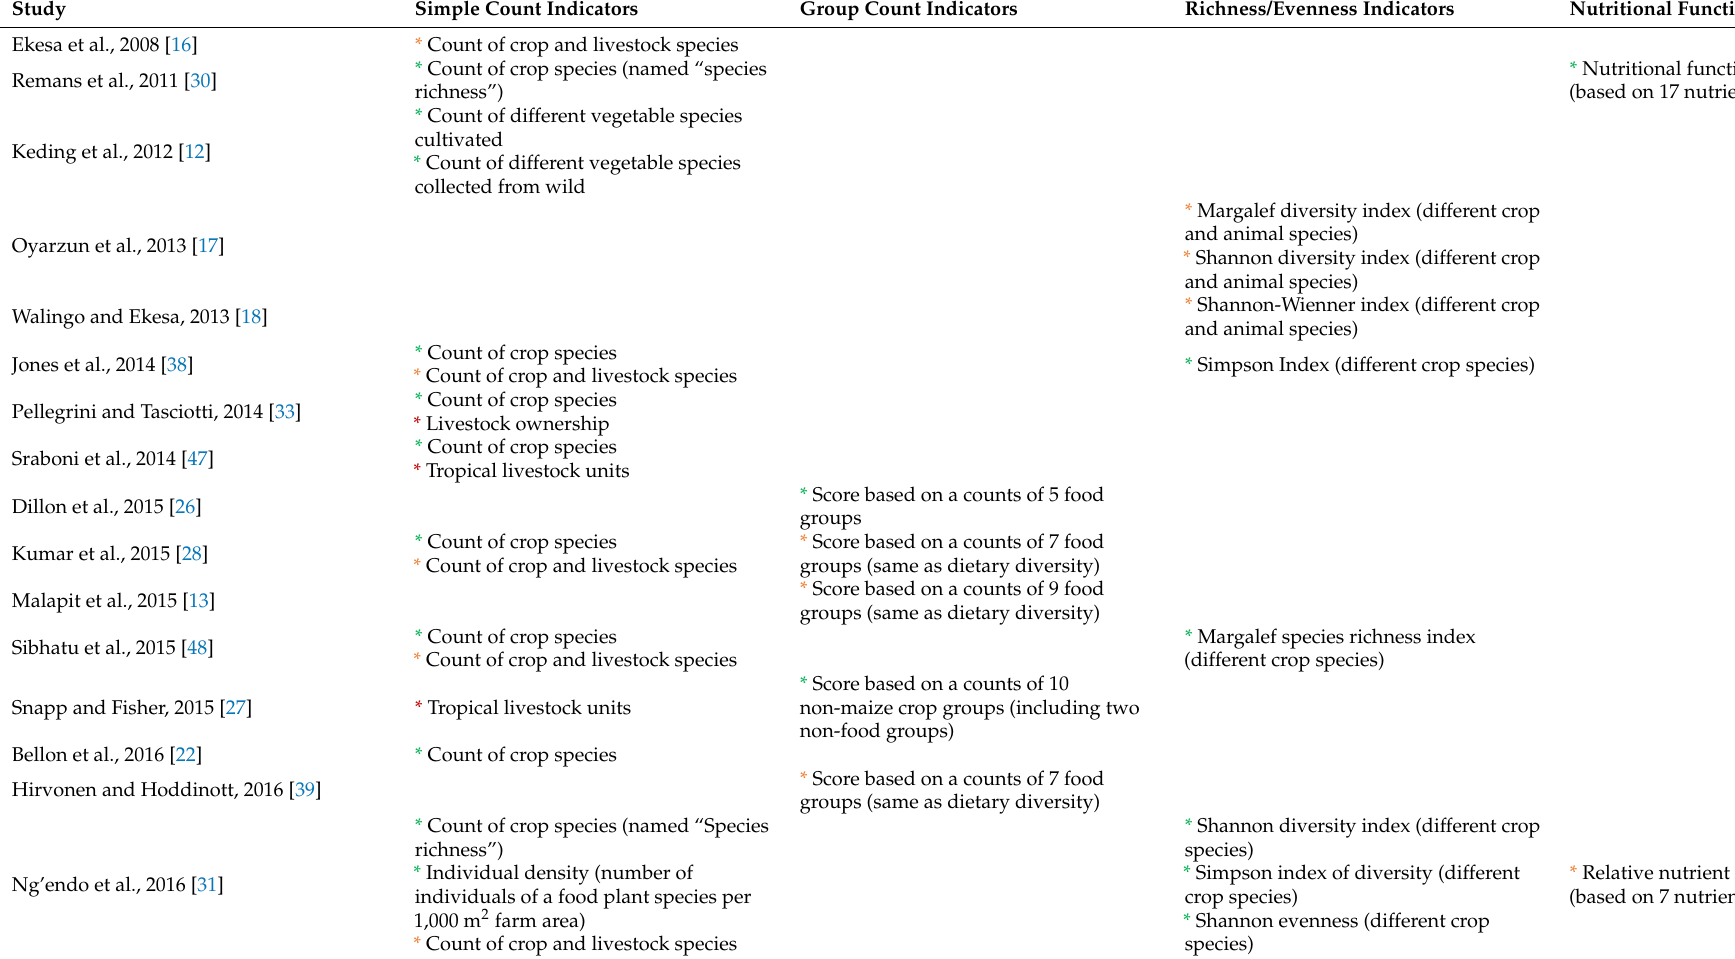
Table A1. Indicators used to Measure Agricultural Production Diversity ( n =